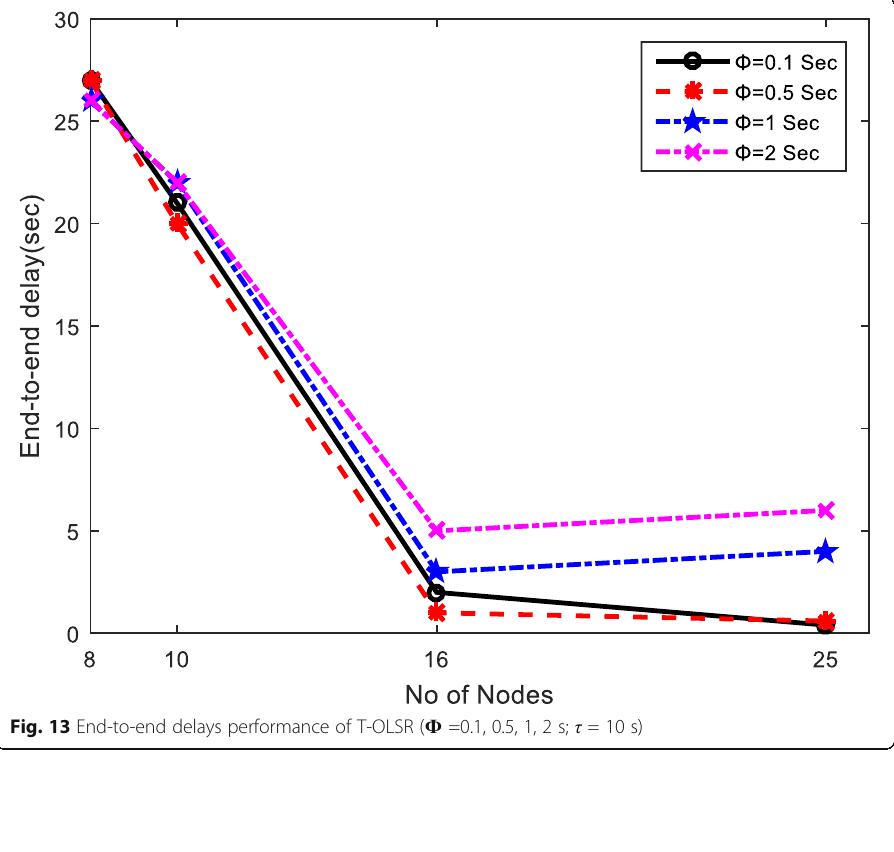
Fig. 13 End-to-end delays performance of T-OLSR ( Ф =0.1, 0.5, 1, 2 s; τ = 10 s)